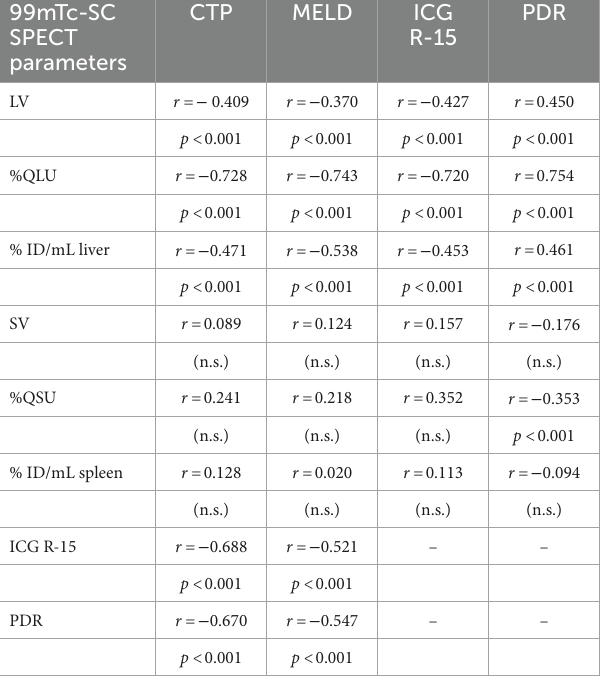
TABLE 2 Correlation# between quantitative Q-SPECT/CT and CTP, MELD scores, ICG